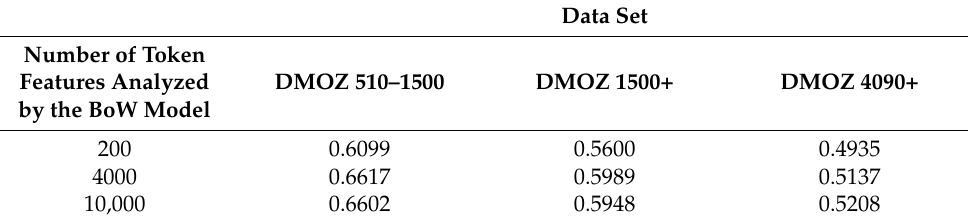
Table 2. Influence of BoW model quality on final classification performance of the AlBERT model on data instances obtained with Text Guide. Experiments were performed with Text Guide by using five occurrences of important token features found in the original text instance, and XGBoost was used to obtain feature importance.